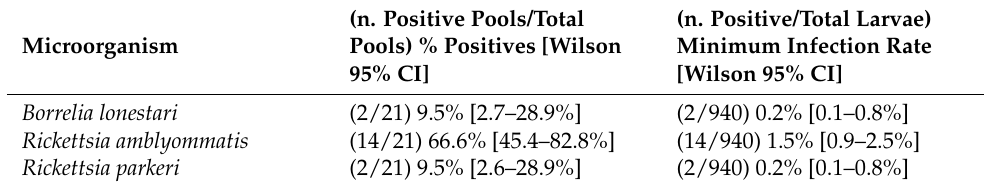
Table 3. Microorganism prevalence in 21 Amblyomma americanum larval pools collected in greenspaces in Alachua County, Florida, USA.